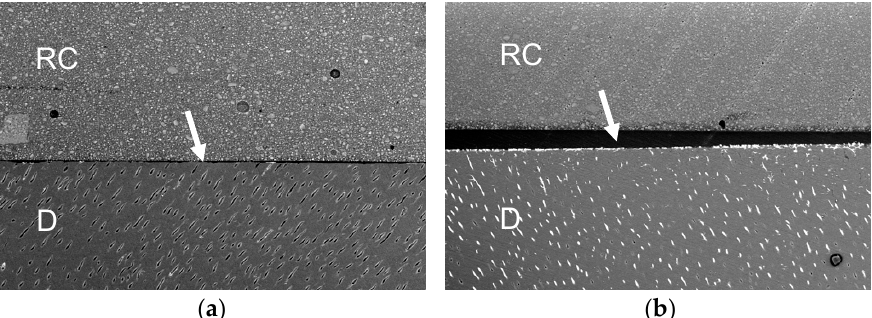
Figure 1. Representative backscatter SEM images of the resin–dentin adhesive interfaces of SBU after 24 h. ( a ) Received by the manufacturer; ( b ) expired. RC, resin composite. D, dentin. White arrows indicate adhesive layer; 250x.